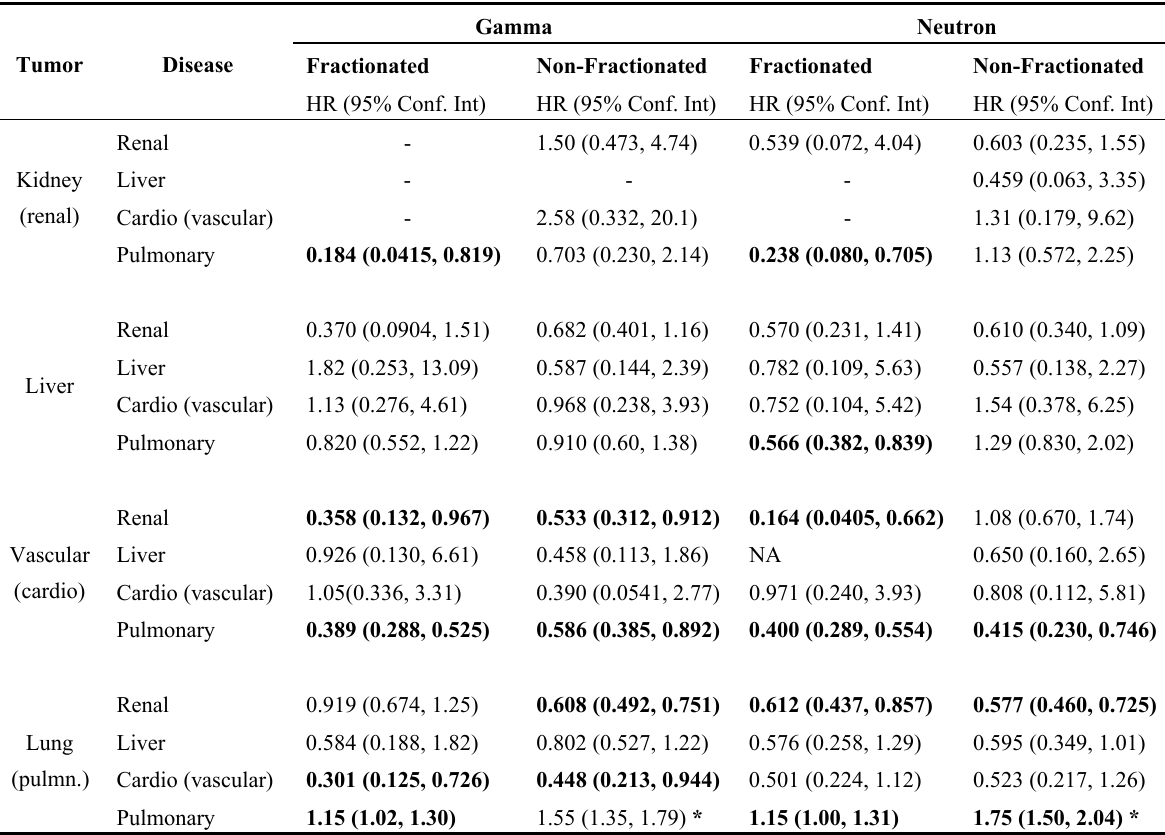
Table of Cox regression hazard ratios and accompanying 95% confidence intervals in gamma and neutron radiation models corresponding to the estimated hazard ratio of the disease of interest. Models used to obtain these estimated HR coefficients used a linear dose term only, due to the lack of a significant quadratic dose term in the previous cancer based models. Bolded values indicate significant hazard ratios at the 5% level. * indicates that the particular model did not satisfy the proportional hazards